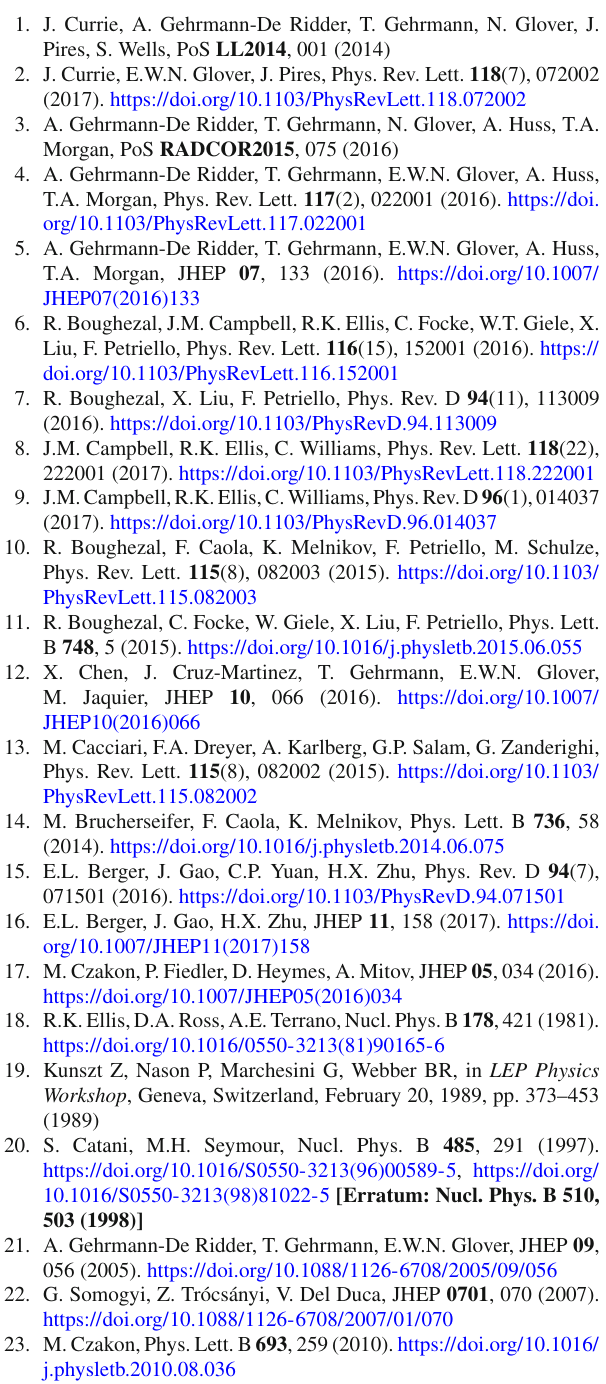
Table 3 Results for all the double-real integrals at the point y 13 = 0 . 9 with i = 1, j = 2, and k = 3. The table shows the O ((cid:9)) coefficient of each integral, I ( 2 ), ij , according to the normalization indicated in Eq. (83). For each case C x III ( x ∈ { 1 , 2 , 3 , 4 } ) the result presented cor-